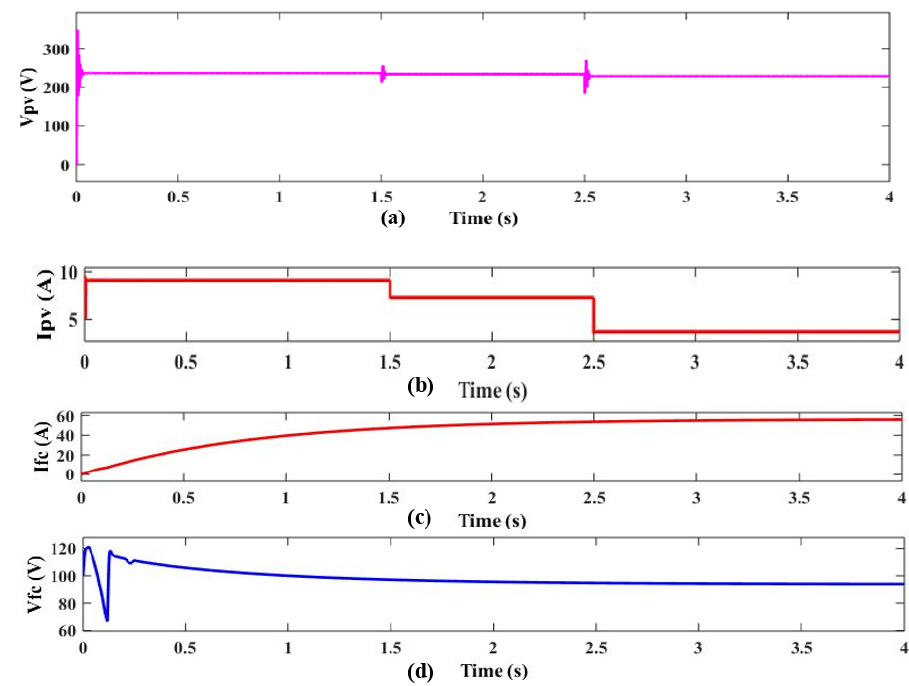
Electronics 2021 , 10 , 2541 Figure 12. MPPT with triangular MF—( a ) PV voltage ( b ) PV current ( c ) Fuel cell current ( d ) Fuel cell voltage.